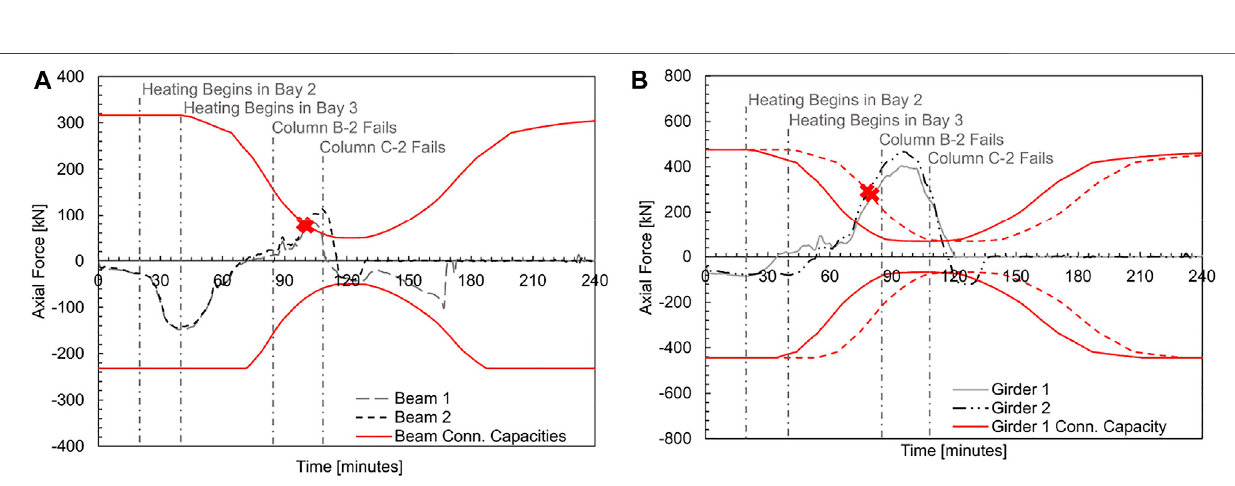
Frontiers in Built Environment |